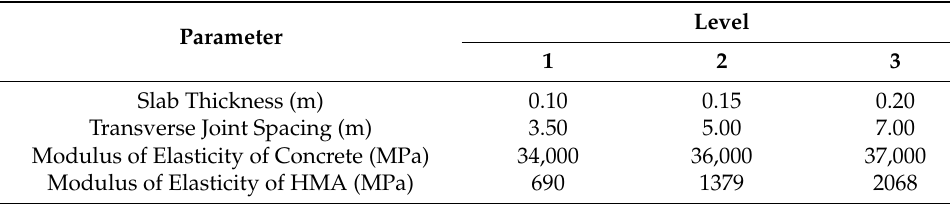
Table 5. The parameters and levels used in the Taguchi method.